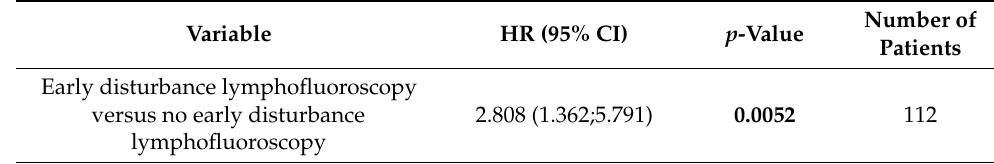
Table 3. Univariate analysis of